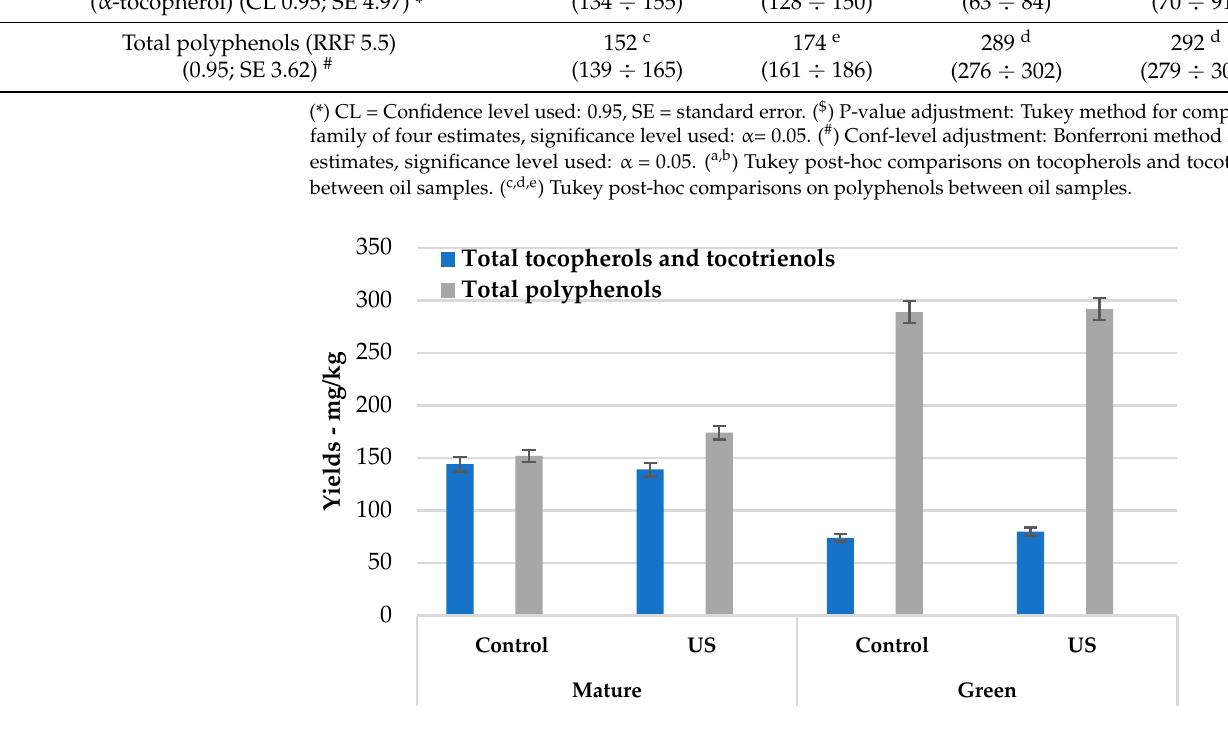
Figure A2. Total tocopherol and tocotrienol (almost α -tocopherol only) and polyphenol contents according to Taggiasca ripening and processing technology (mean ± SE